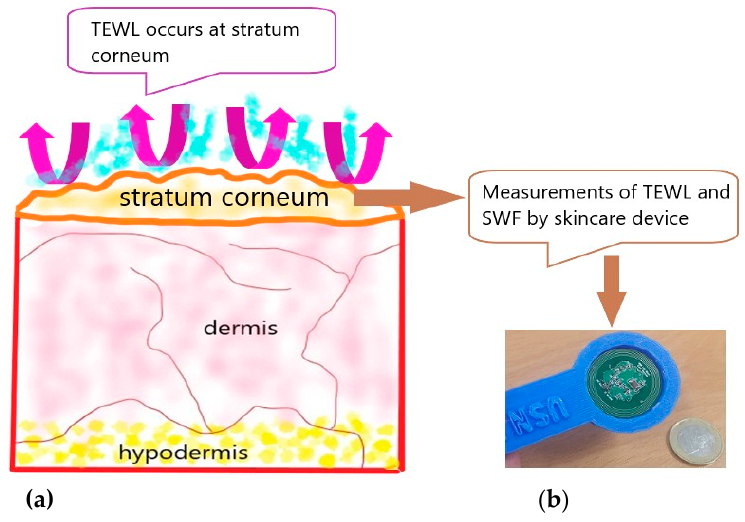
Figure 1. ( a ) Typical skin layer structure; ( b ) skincare sensor device tag.